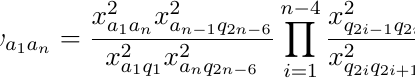
Figure 3 . The choice of OPE vertices which are equivalent to the OPEs O σ ( x ) and O O k a 2 α